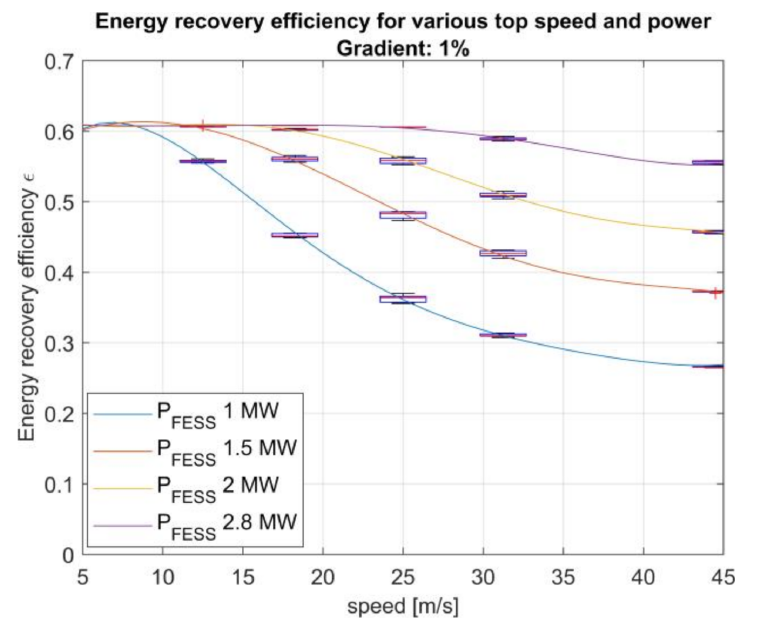
Figure 8. One percent gradient energy recovery efficiency for multiple top speeds and FESS powers.